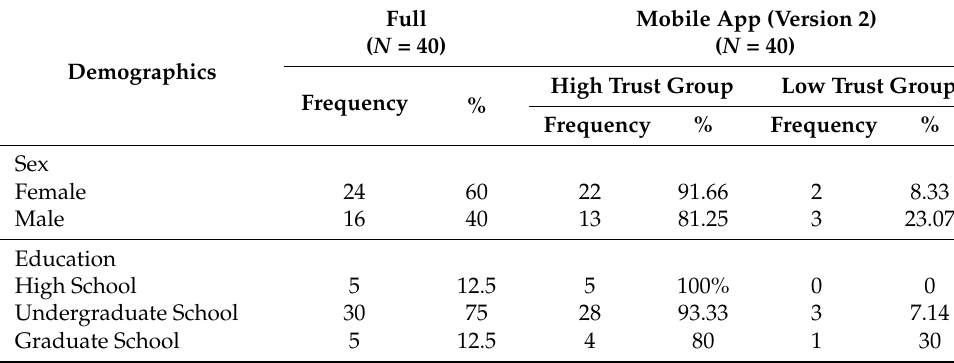
Table 12. Demographic Results for Trust Evaluation of the Mobile Application Version 2.